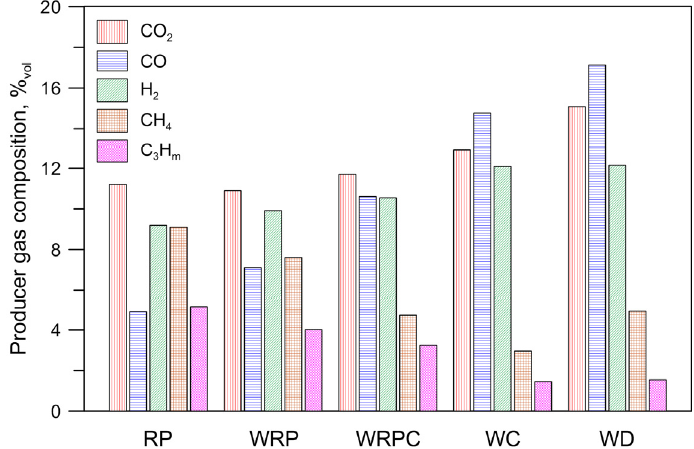
Figure 4. Concentration of the main components of the dry product